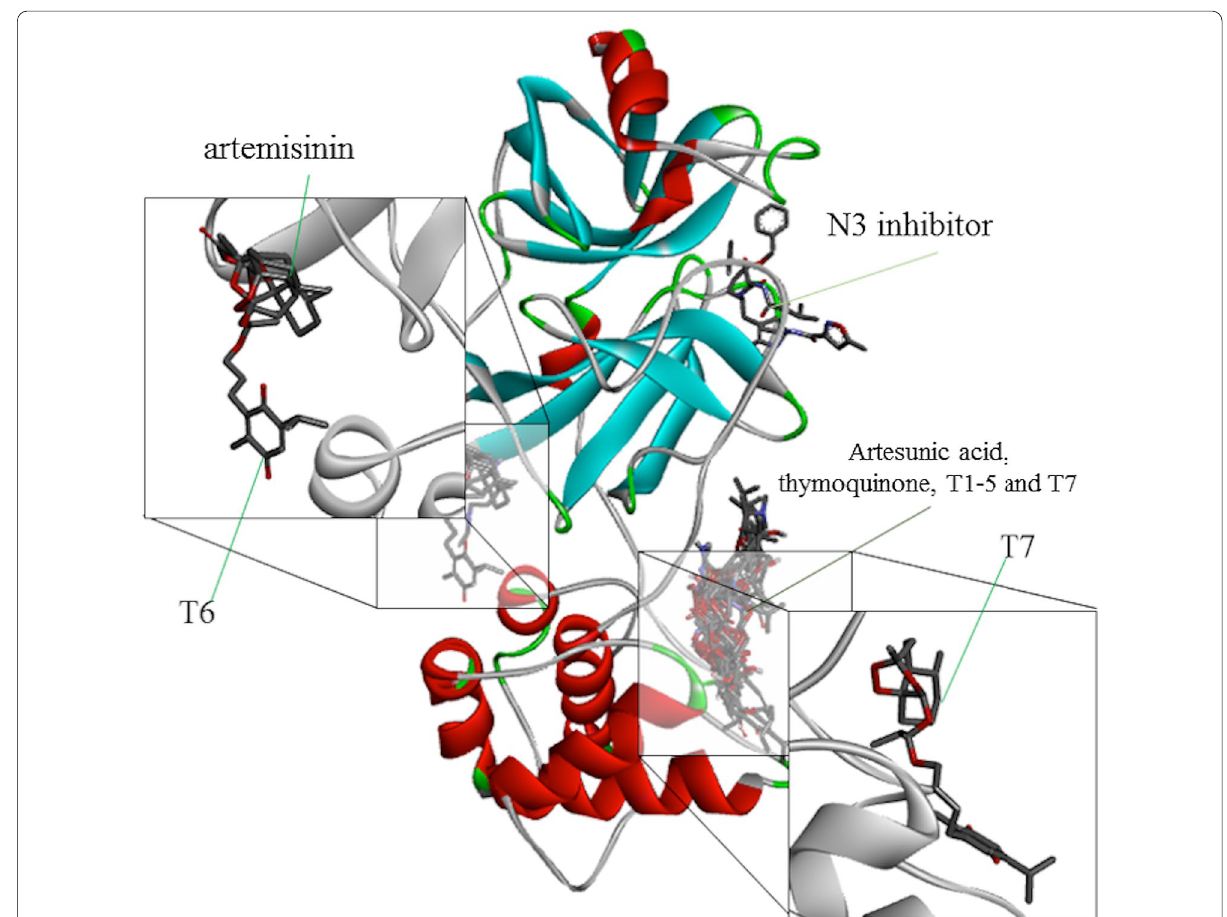
Fig. 9 Representation of the interaction of hybrids T6 and T7 as molecules with Mpro